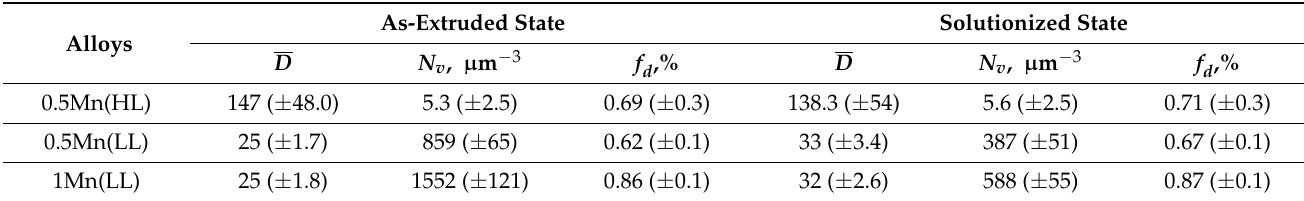
Table 2. Quantitative TEM results of dispersoids in experimental alloys.